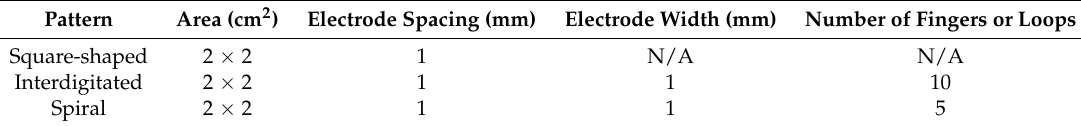
Figure 12. Experimental results of sensor capacitance’s change with different patterns. Table 3. Parameters of FEF (fringing electric field) sensors in Figure 12.